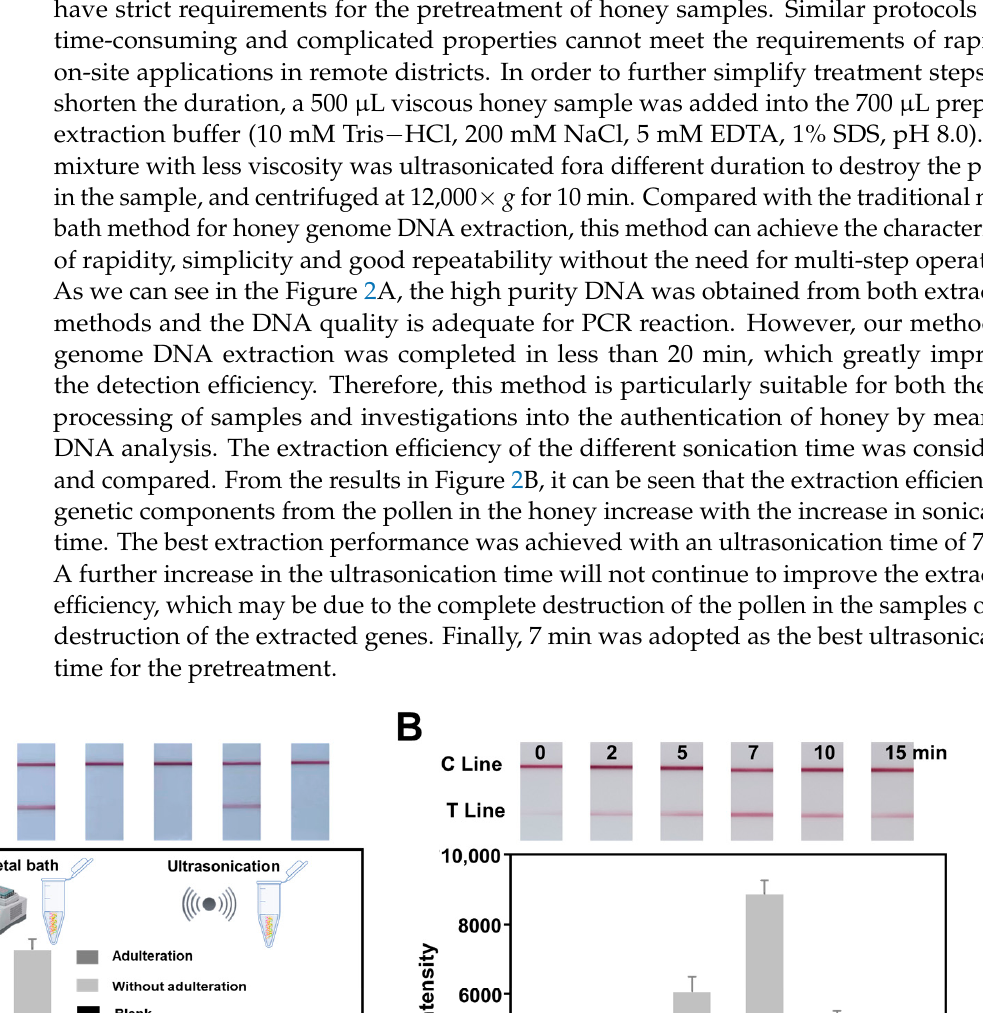
5 of 10 Figure 1. The schematic diagram of the rapid genetic authentication strategy for honey. The target DNA is first extracted by ultrasonication and amplified to produce the enormous functional ampli- cons with the designed primer set. The products of on-site amplifications were skillfully integrated